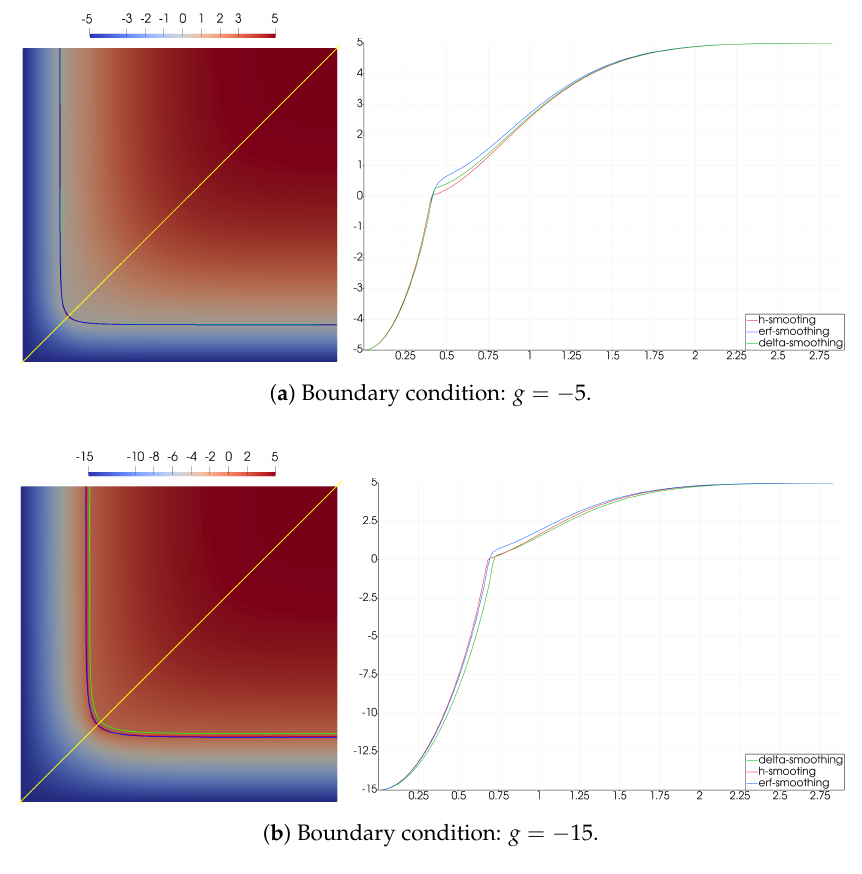
Figure 5. Two-dimensional problem. Numerical solutions using error function smoothing (blue color), smoothing in one spatial interval (red color), and linear smoothing using the ∆ interval (green color). Left: solution at the final time. Right: solution on line x 1 = x 2 at the final